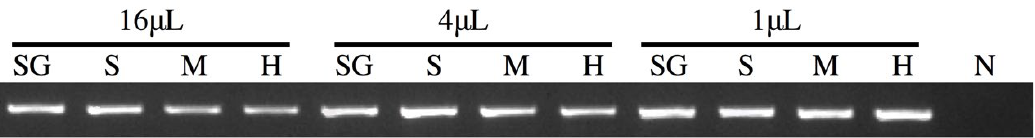
Figure 2. Comparison of DNA extraction efficiency of four types of filter paper under different initial blood volumes. Three different volumes (16 μL, 4 μL, 1 μL) of anticoagulant whole blood extracted from crucian carp were used for DNA extraction. Then, extracted genomic DNA was used as the template for 16s rRNA gene amplification and water was used as the negative control. SG,